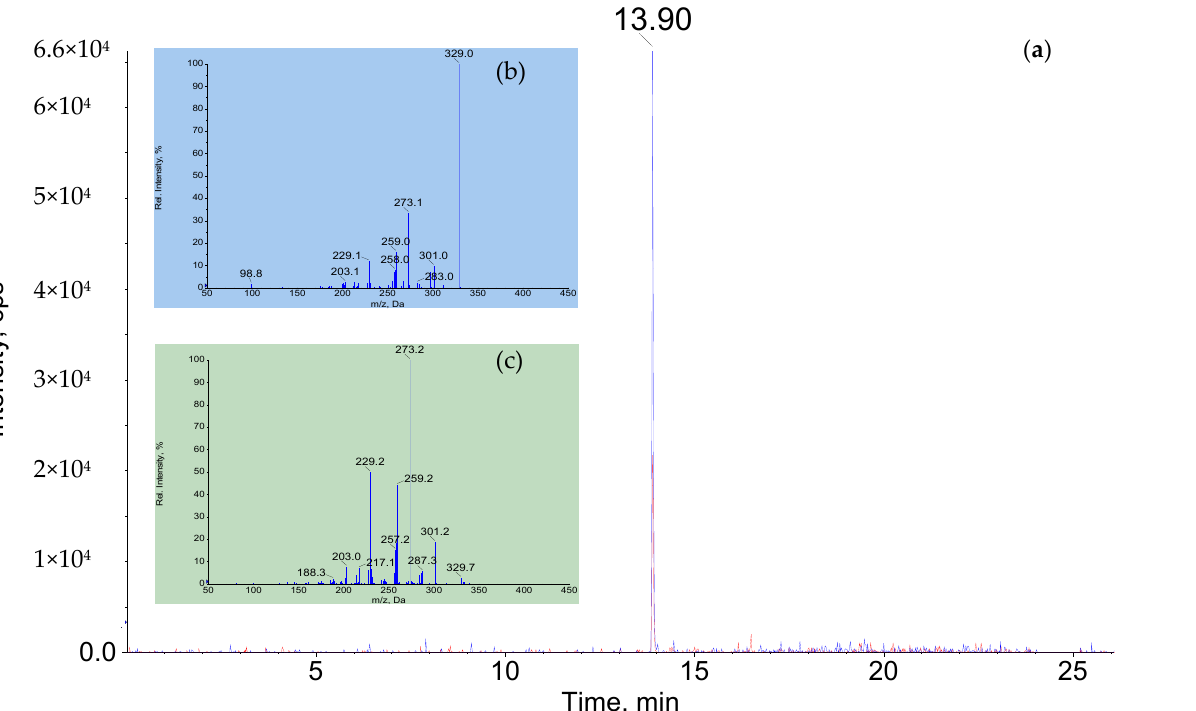
Figure 4. ( a ) Typical MRM chromatogram of aflatoxin M1 in bovine milk; ( b ) Product ion spectrums of aflatoxin M1 in bovine milk; ( c ) Product ion spectrums of aflatoxin M1 in standard product ion spectrums in database library.